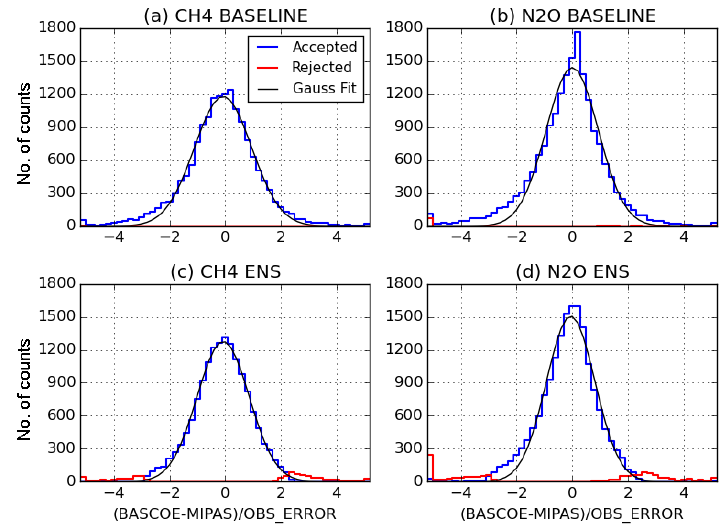
Figure 7. Histograms of counts of (BASCOE-MIPAS)/MIPAS_ERROR on 20 August 2008 for BASELINE (top row) and ENS (bottom row) experiments and for CH 4 (left column) and N 2 O (right column). Blue and red lines correspond to MIPAS observations accepted and rejected by the BgQC respectively. Black line is a Gaussian fit of the blue line.